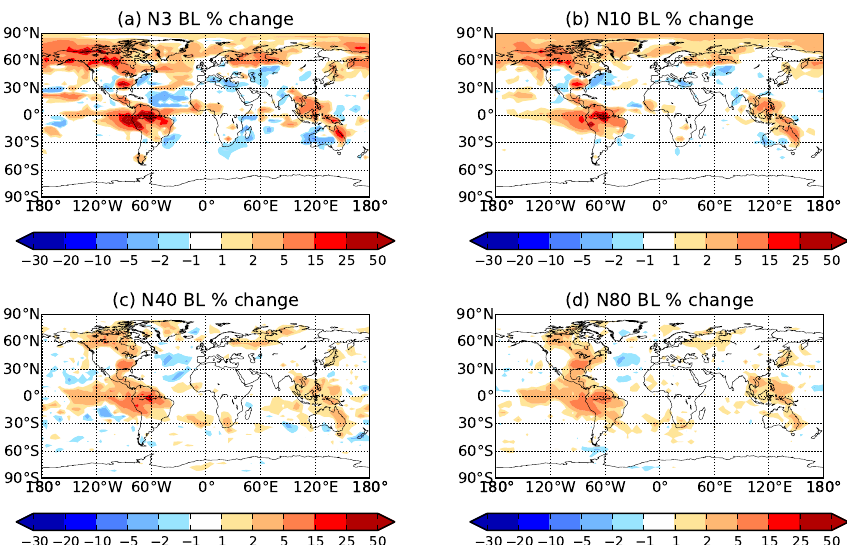
Fig. 6. The July-mean boundary-layer change in N 3, 10, 40 and 80 due to the addition of CI+SO 2 chemistry